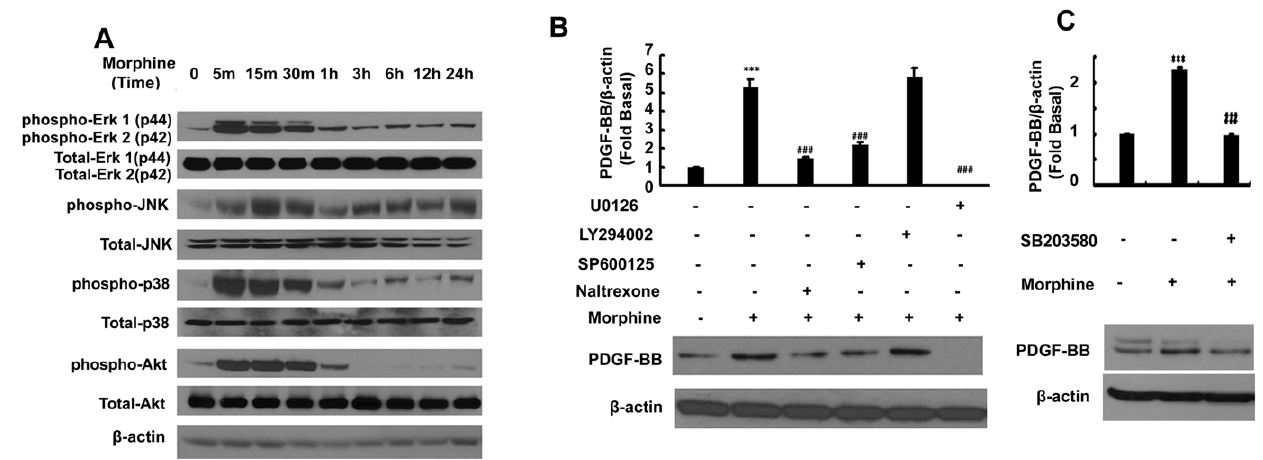
Figure 2. Opioid receptor, Erk1/2 and JNK MAPK but not PI3K/Akt pathways are involved in morphine-mediated induction of PDGF-BB in HBMECs. ( A ) Time-dependent activation of Erk1/2, JNK, p38 and Akt by morphine as evidenced by western blot analysis. Pretreatment of HBMECs with the inhibitors specific for Erk1/2-U0126 20 m M (B), JNK-SP600125 20 m M (B) and p38-SB203580 20 m M (C) but not Akt-LY294002 10 m M) (B) pathways abrogates morphine-mediated induction of PDGF-BB. All the data are presented as mean 6 SD of three individual experiments.